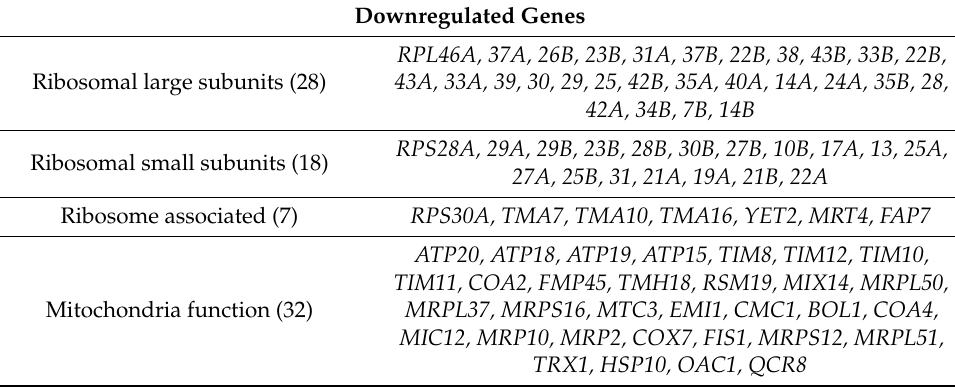
Table 6. A list of downregulated genes showed the impact of red CdSe/ZnS QDs on membrane trafficking, cell wall organization, cytoskeleton, metabolism, and protein translation. Genes are sorted by protein